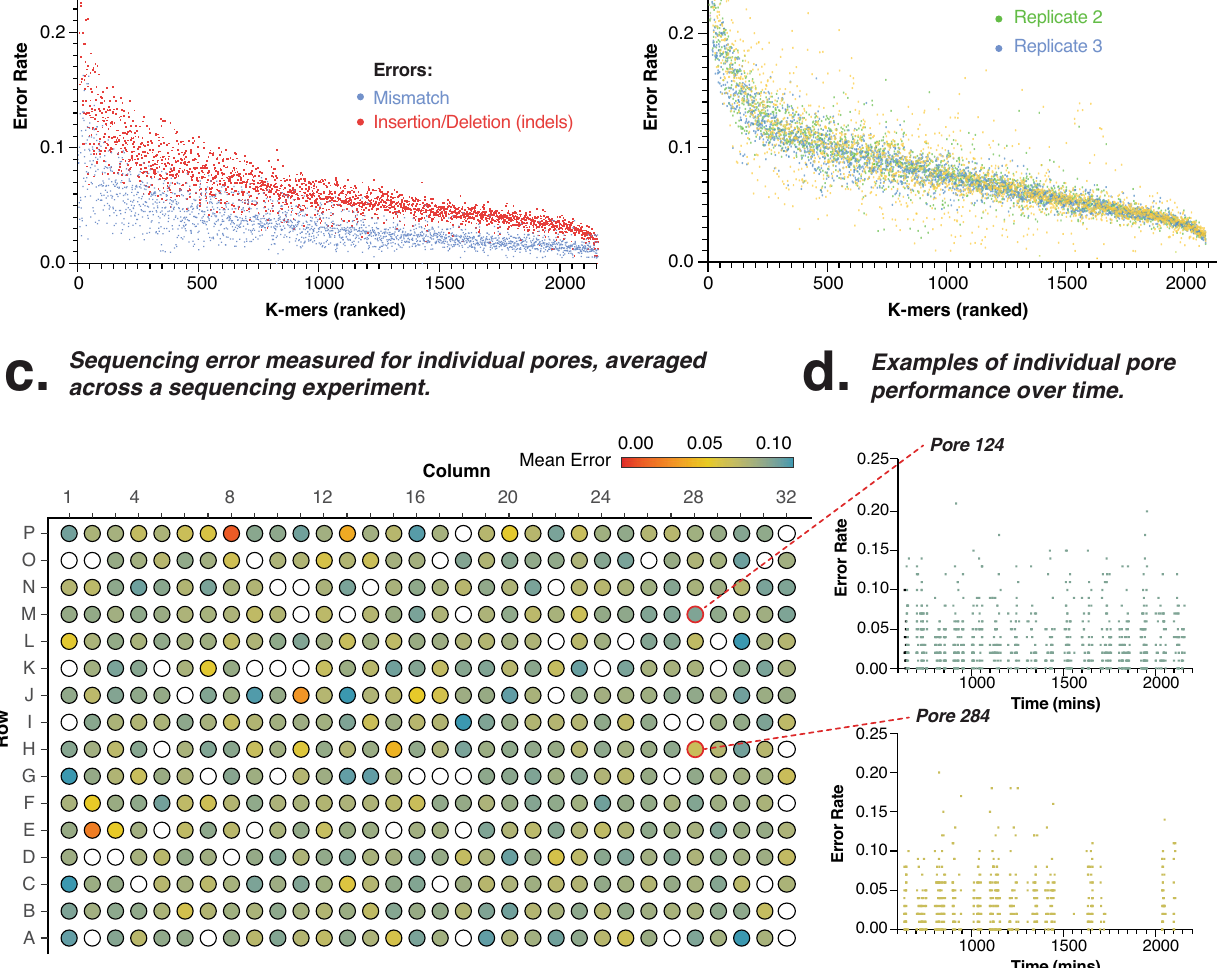
diagram shows an Oxford Nanopores Technology (ONT) fl owcell matrix with indi- vidualporescolouredaccordingtomeansequencingerroracrossthedurationofan experiment. d Scatterplotsshowsequencingerrorpro fi lesforexampleporesacross the duration of an experiment. Source data are provided as a Source Data fi